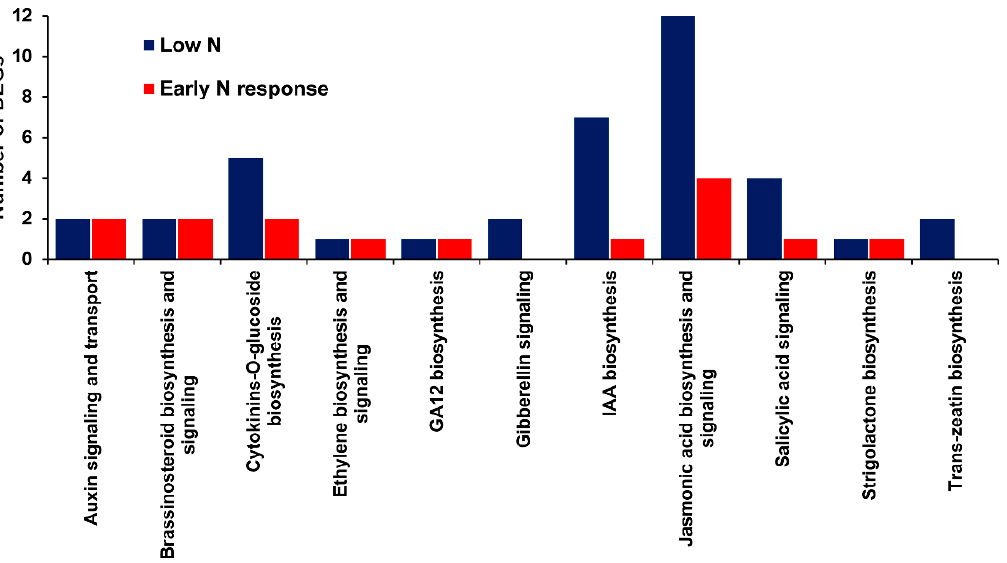
Figure 9. Pokkali-specific low N response DEGs co-localized on chromosomes with chlorate resistance, root development and nitrogen use efficiency (NUE) quantitative trait loci (QTL). Locus names in red font: downregulated, blue font: upregulated. QTLs included were chlorate resistance (kclo3rs): black solid bar; root number (rtnb): green diagonal bar; root volume (rtvol): red solid bar; root depth (rtdp): blue diagonal bar; root thickness (rtth): blue solid bar and root length (rtlg): red diagonal bar.